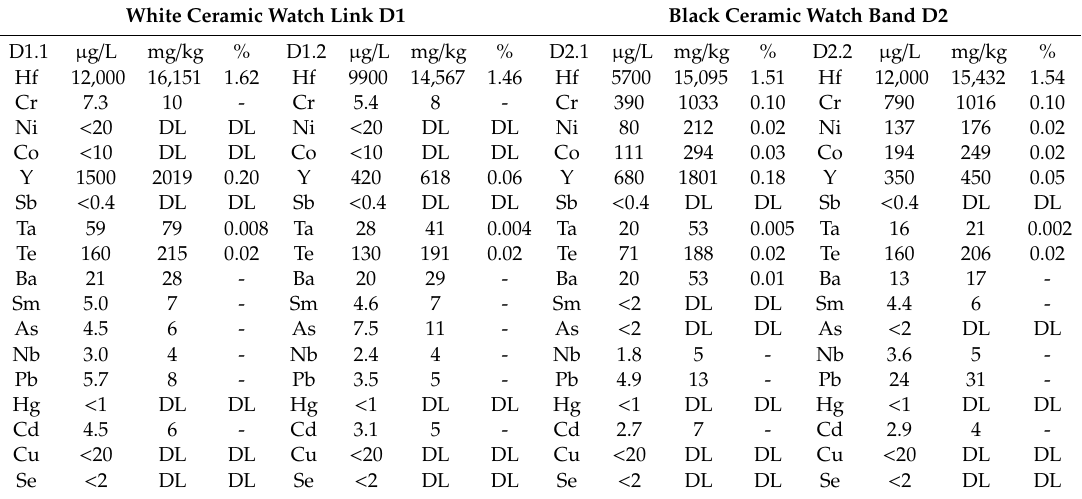
Table 9. Trace analysis in the solutions; Analysis results and conversion in units [mg / kg] and [%]. 0.01% = 100 mg / kg. DL: Detection limit.